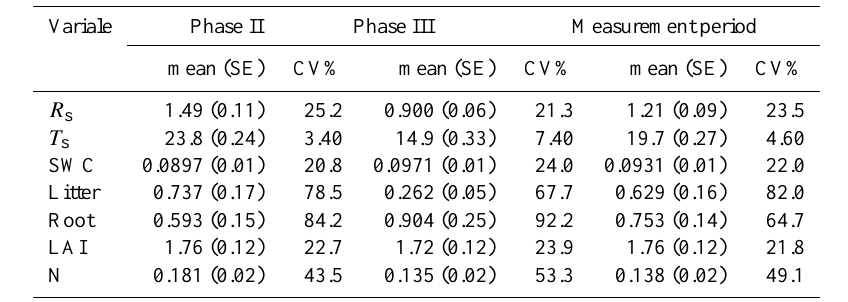
Table 1. Average values (standard error in brackets) and CV (%) for micro-hydrometeorological factors and plant-related factors over the three plant phenophases and measurement period. The time scale for the means was showing in Fig. 2. R s : soil respiration (µmol CO 2 m − 2 s − 1 ) ; T s : soil temperature at 10cm depth ( ◦ C); SWC: volumetric soil water content (m 3 m − 3 ) ; Litter: litterfall (kgm − 2 ) ; Root: root biomass (kgm − 3 ) ; LAI: leaf area index (m 2 m − 2 ) ; N: soil nitrogen content at 0–25cm depth (gkg − 1 ) ; Phase I: leaf expansion; Phase II: flower-bearing; Phase III: coloration-defoliation.